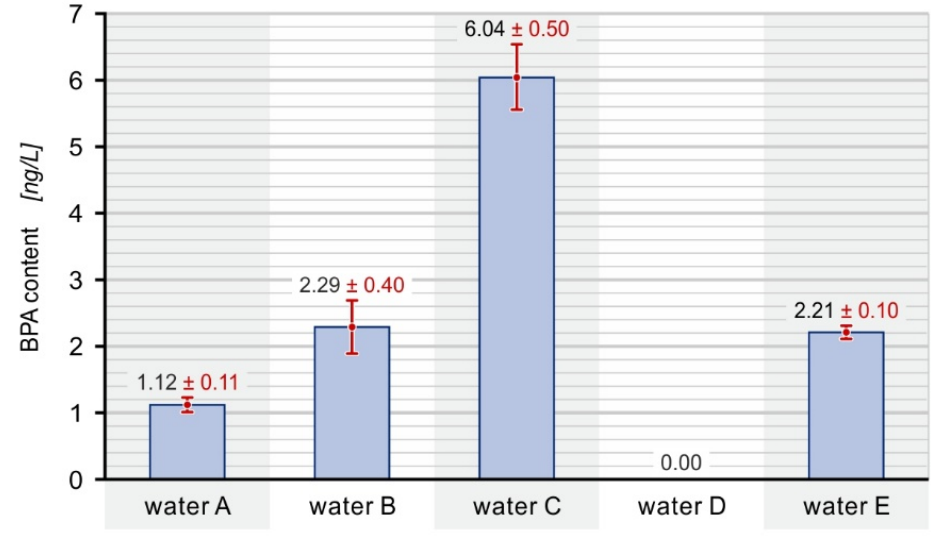
Figure 4. The content of bisphenol A in bottled water immediately after purchase. Bisphenol A was detected in all water samples, except for water D. Its highest concen- tration was determined in water C. The obtained values correspond well with the values found in the literature, ranging from 4.04 ng/L [34] to 4.6 ng/L [35]. There are several aspects that may be the cause of the differences in the content of BPA in the tested samples, e.g., the material of the bottle, the material of the cap, the method of storage at the stages of production and sale, and the materials of the installation used to draw water and fill the